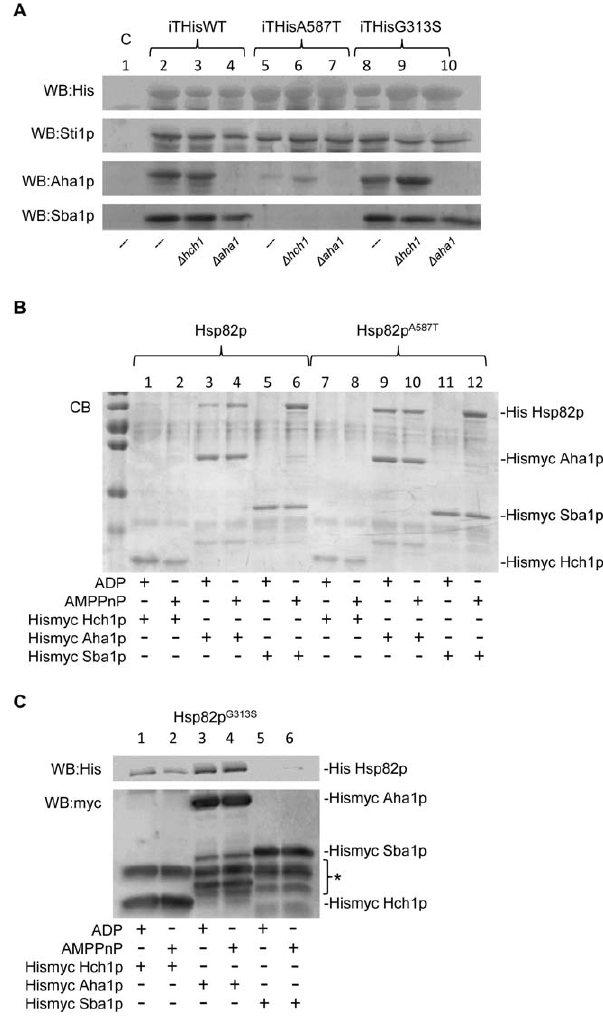
Figure 8. Analysis of complexes formed with Hsp82p, Hsp82p G313S and Hsp82p A587T . A. Ni-NTA pulldown of His-tagged Hsp82p from lysates from yeast expressing either untagged wildtype Hsp82p (Lane 1), HisHsp82p (Lanes 2–4), Hsp82p A587T (Lanes 5–7) or Hsp82p G313S (Lanes 8–10). Isolated complexes were analyzed by western blotting with antibodies to the indicated proteins. Genetic background of each strain is indicated beneath each lane. B. 5 m M Hsp82p or Hsp82p A587T was incubated with 5 m M of the indicated His- myc tagged co-chaperone and either 1 mM ADP (odd lanes) or 1 mM AMPPnP (even lanes). Complexes were isolated with beads coupled to anti-myc monoclonal antibody 9E10, run on SDS-PAGE and analyzed by coomassie blue staining (CB). C. 5 m M Hsp82p G313S was incubated